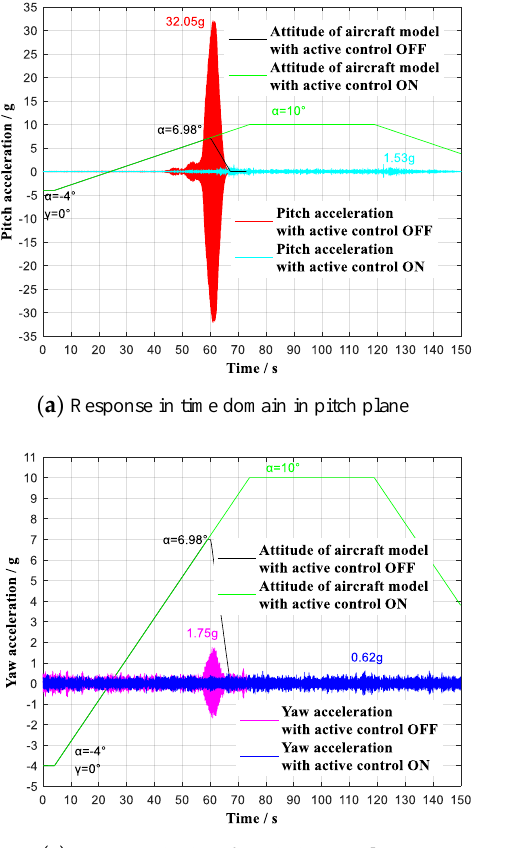
Figure 10. Photograph of the multidimensional vibration suppression system installed in a continuous transonic wind tunnel.